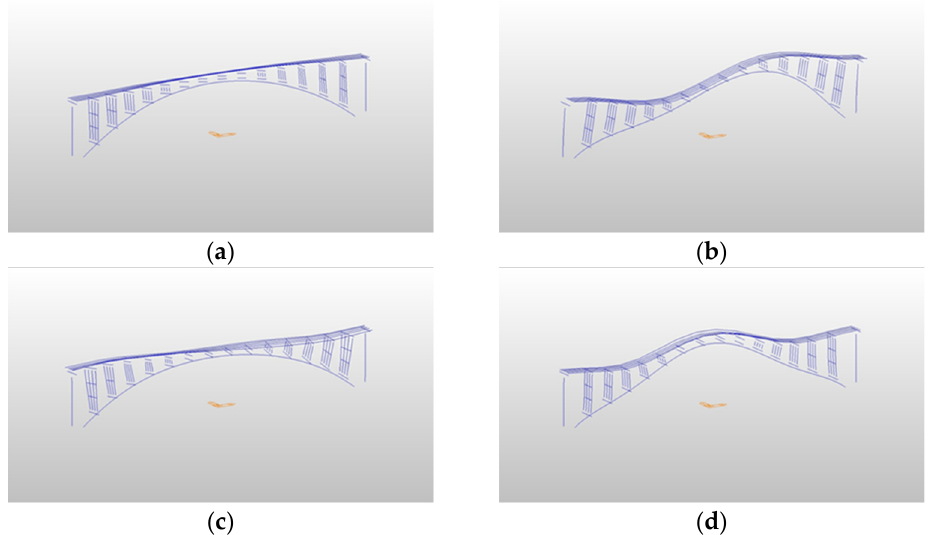
Figure 9. The first − to fourth − order vibration shape of the arch bridge. ( a – d ): first order to fourth order). Table 2. Frequency and vibration shape of the arch bridge.